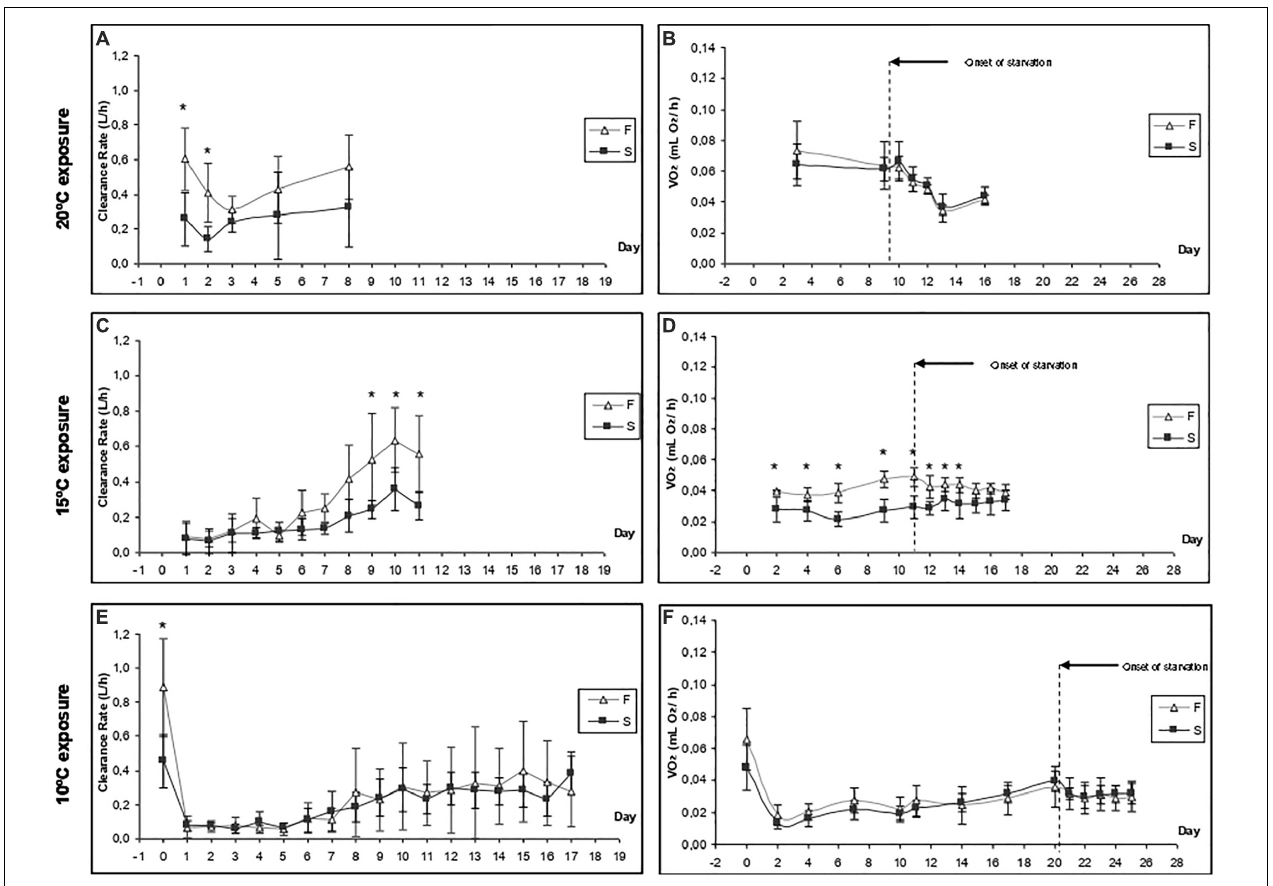
FIGURE 2 | Time-course of the clearance rate (A,C,E) and oxygen consumption (B,D,F) of F 20 and S 20 mussels at three exposure temperatures (20, 15, and 10 ◦ C). Five individuals from each group were monitored in each experimental condition. Asterisks indicate significant differences between fast- and slow-growing individuals (ANOVA, p <